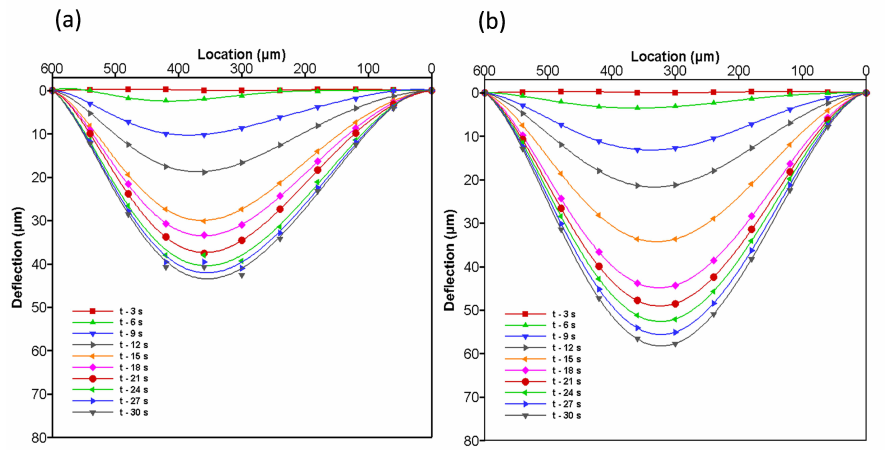
Figure 11. Deformation of membrane in the A-A’ cross-sectional plane is shown in various time steps at an input flow rate of 8 µ L/min are used in both L/W-ratio models ( a ) L/W = 0 and ( b ) L/W = 0.65